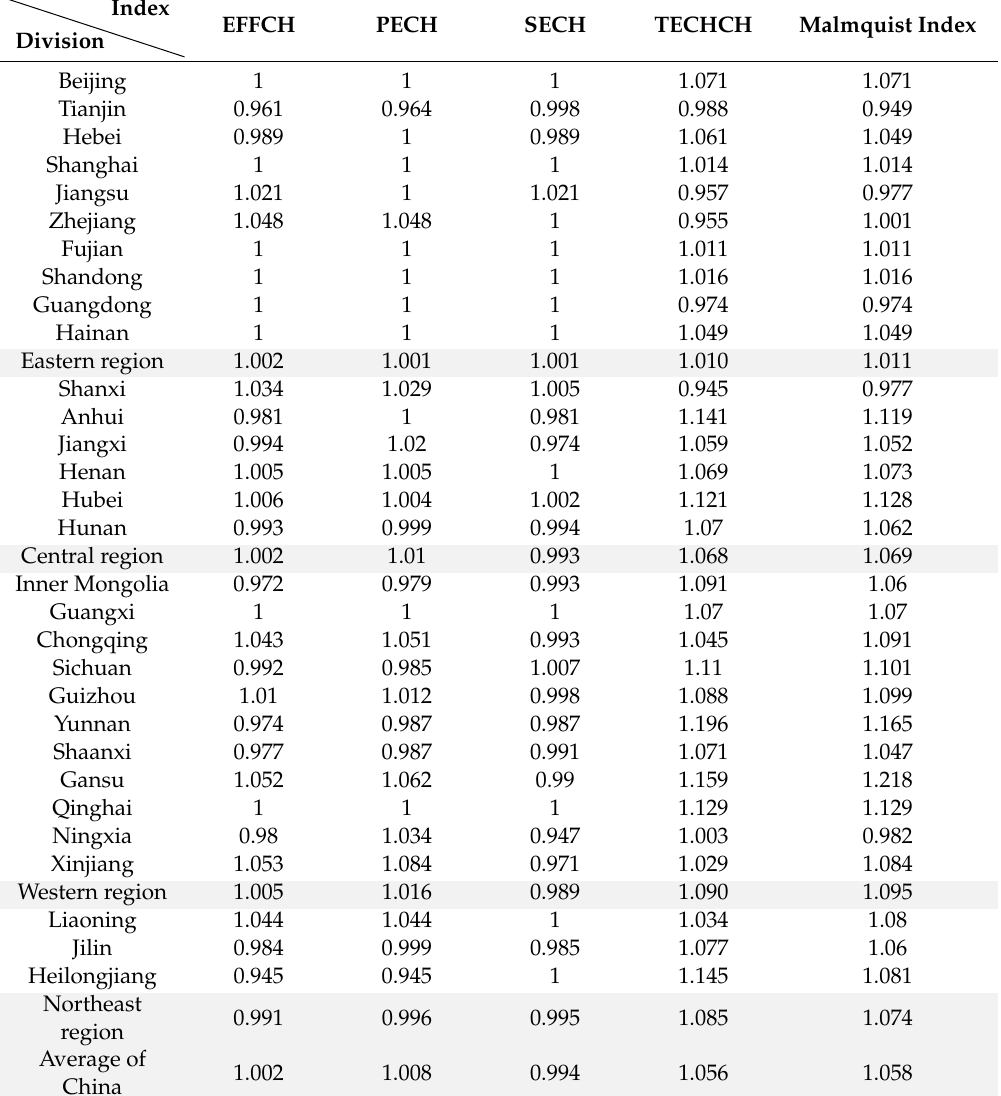
Table 3. Malmquist index and decomposition values of EFPE in China